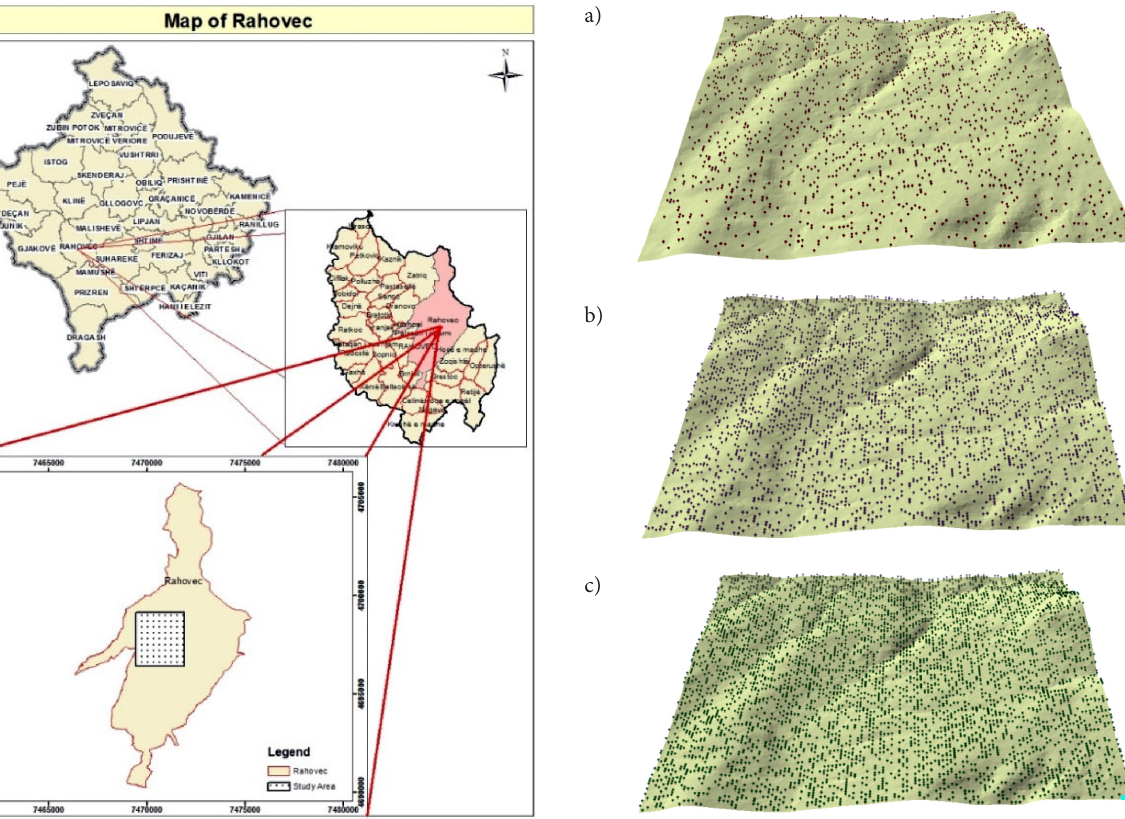
Figure 1. Study area (Rahovec) Figure 2. Control points: a) 10% of base